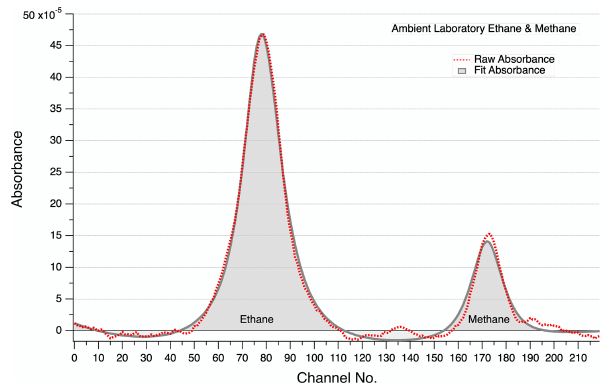
Figure 6. Ambient ethane and methane raw and fit spectra acquired by sampling laboratory air. The spectra are in channel numbers. The fit indicates an ethane mixing ratio of 4 . 23 ± 0 . 025ppbv, while the methane corresponds to 1591 ± 30ppbv. The methane feature under- lying the ethane feature shown in the previous figure is still present but not evident in the fits here since this feature almost perfectly overlaps with ethane. The methane feature on the right in this scan is clearly underestimated since we have not optimized the width of this feature. The very weak methane feature between ethane and methane also shows up on the raw spectra but is not properly fit